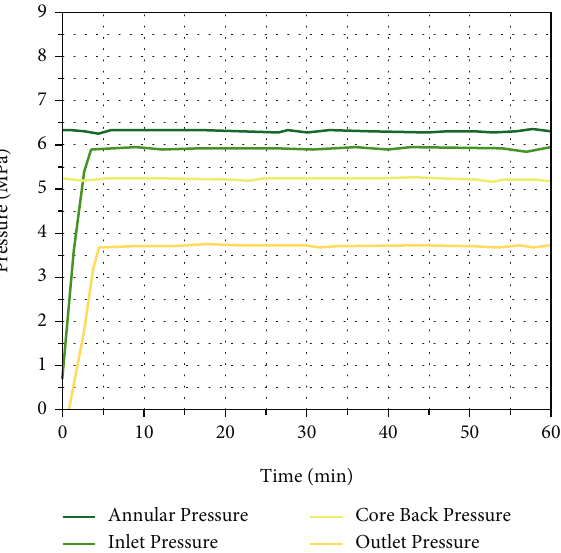
Figure 18: Experiment 11 plugging pressure change.